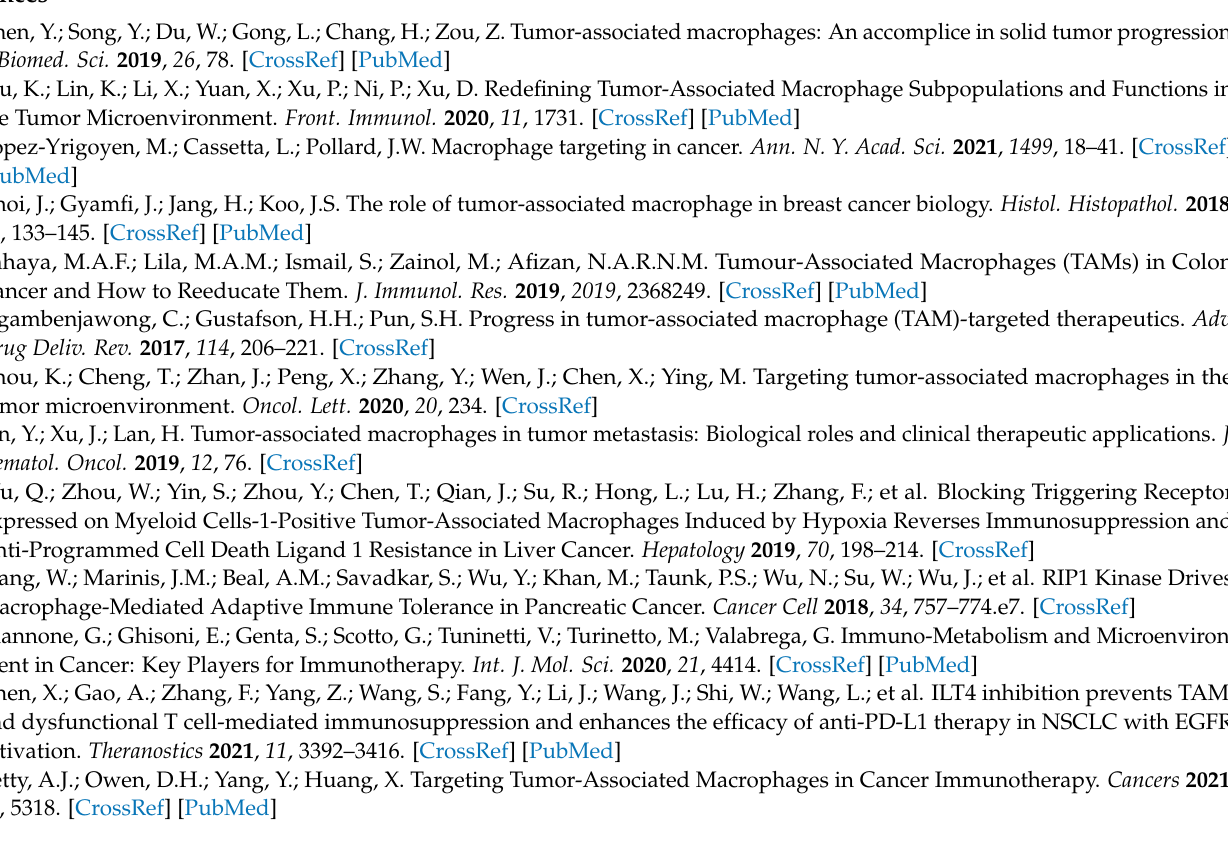
Figure S2: Schematic of Lenti/BCAR, Lenti/MCAR, and Lenti/ESO-TCR vectors. Figure S3: In vitro antitumor efficacy of CAR-T and ESO-T